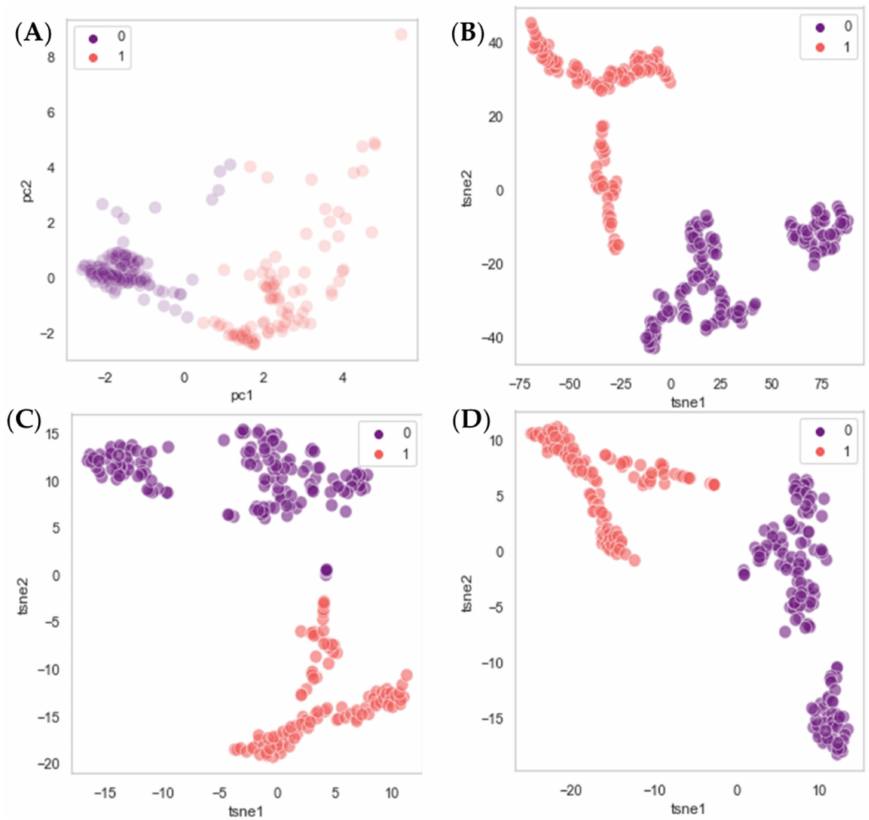
Figure 6. Plots obtained by clustering 255 samples from the Stryker ® video using k-means after dimensionality reduction using two centroids. The dimensionality reduction with PCA ( A ). The dimensionality reduction with t-SNE, using a learning rate of 200 and perplexities of 10 ( B ), 30 ( C ), and 50 ( D ). Since two centroids are being used, frames were divided into classes 0 and 1. When using PCA, the axis corresponds to the two main principal components (pc), whereas in the case of the t-SNE ones to the two main t-SNE